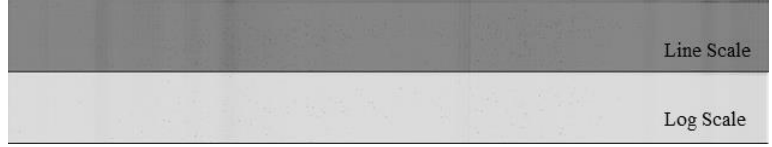
Figure 10. Image after yaw correction. Figure 11. Image after pitch and yaw correction.